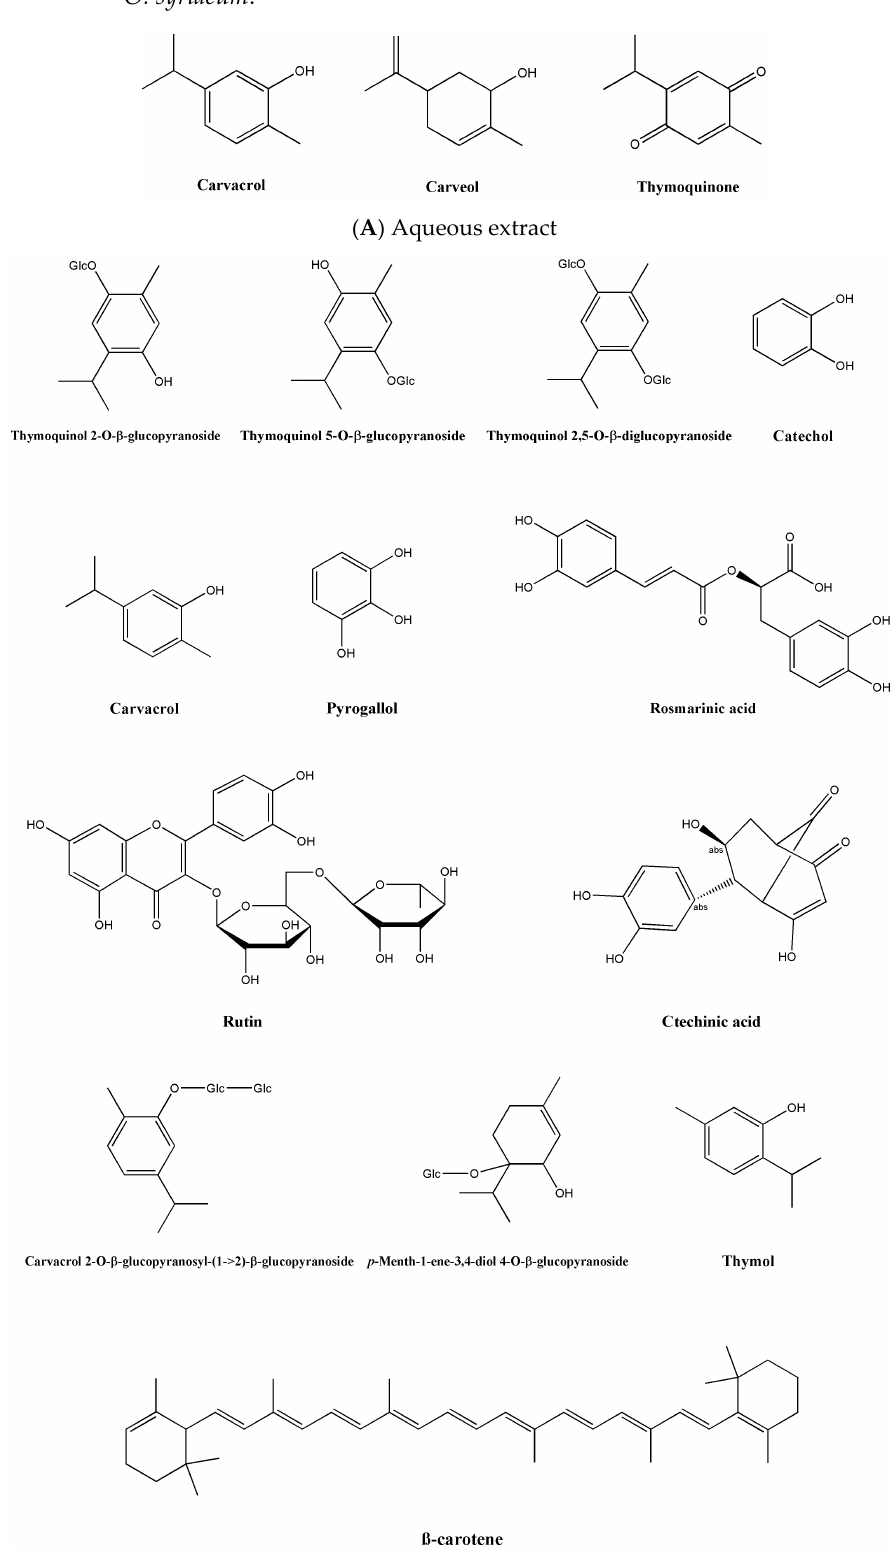
Table 1 summarize the main phytochemical constituents of the different extract types of O. syriacum